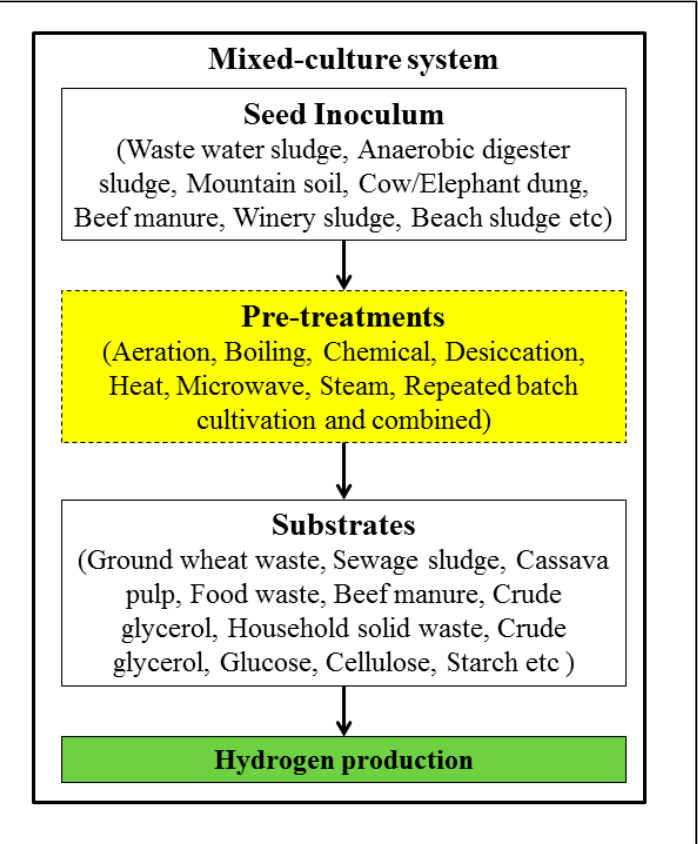
Figure 2. Different types of pretreatment used for the selection of hydrogen producers from seed inocula.